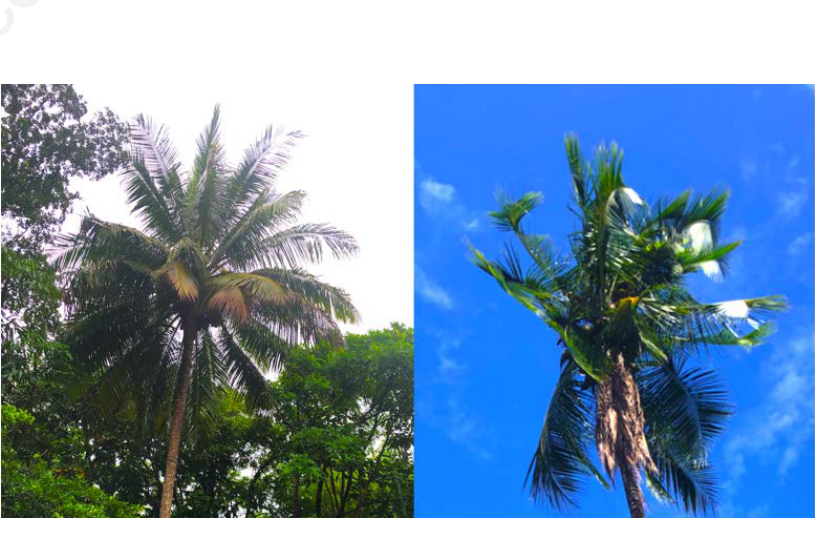
Figure 5. Left: The full dense circular crown of a niu vai. Right. The semi-upright form of the crown of a self-sown niu kafa. It does not have the full dense circular crown and tends to have a more upright crown shape, has fewer fronds and they are smaller in size than niu vai. Intermediate types have a diversity of crown shapes that range from the wild-type niu kafa to the niu vai